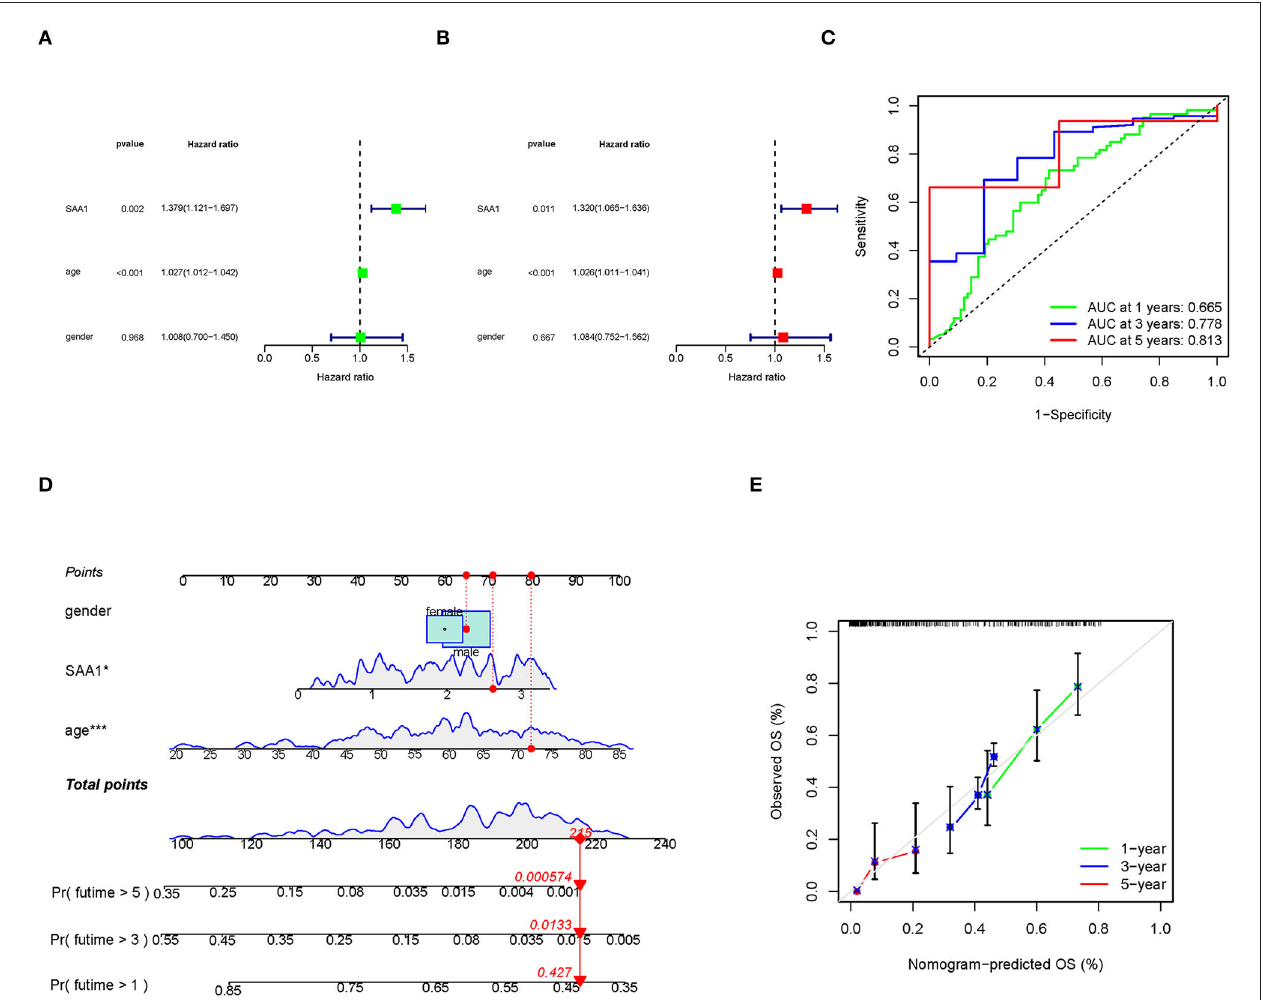
FIGURE 7 | Identification of SAA1 as an independent prognostic factor. (A) Uni-cox forest plot of SAA1 , p = 0.002, HR: 1.379. (B) Multi-cox plot of SAA1 , p = 0.011, HR: 1.320. (C) ROC curves of 1-, 3-, and 5-year OS and AUCs are 0.665, 0.778, and 0.813, respectively. (D) A nomogram that integrated SAA1 , age, and gender and predicted the probability of the 1-, 3-, and 5-year OS. (E) Calibration curves for 1-, 3-, and 5-year OS,